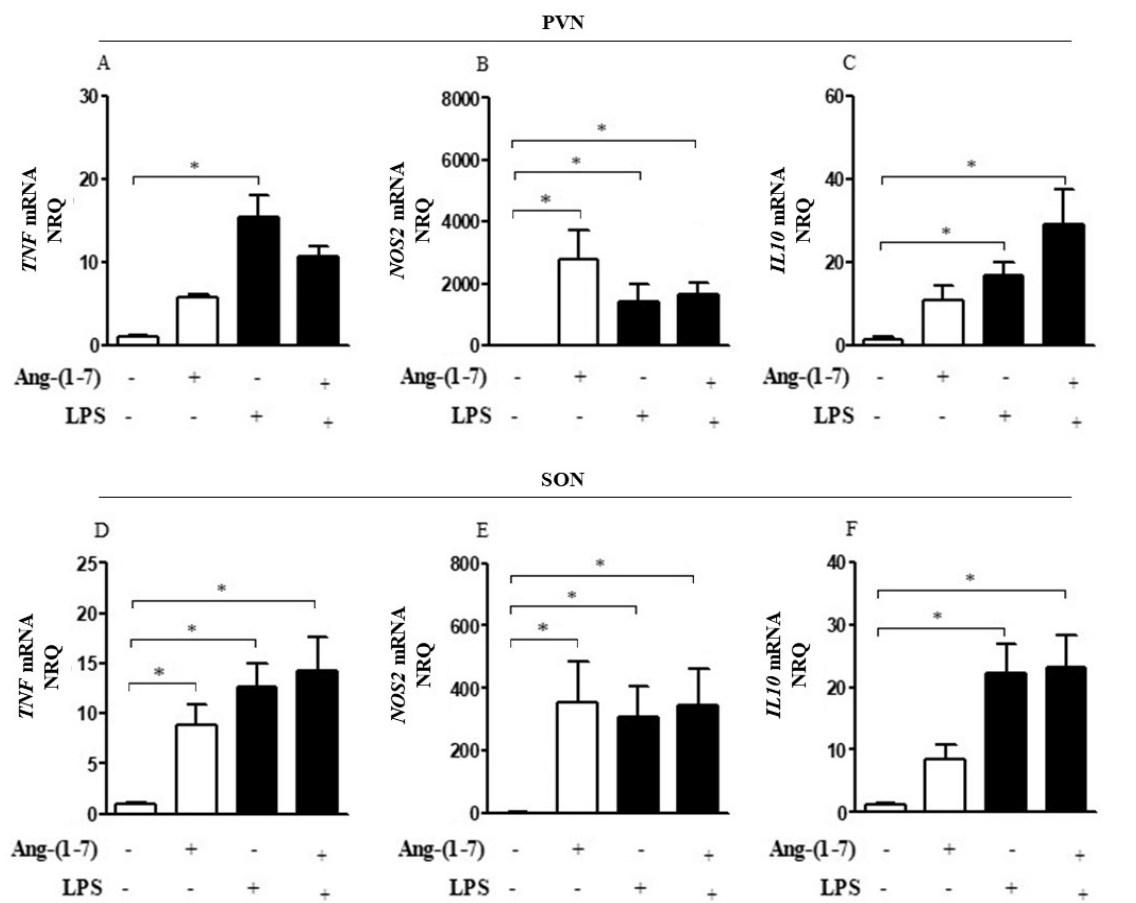
Figure 1. Central administration of Ang-(1-7) did not attenuate neuroinflammation in endotoxemia. Effect of central Ang- (1-7) on the TNF ( A , D ), NOS2 ( B , E ), and IL10 ( C , F ) gene expression in PVN and SON of rats 6 h after LPS administration (1.5 mg/Kg, i.v.). Ang-(1-7) (0.3 nmol in 2 µL, i.c.v.) was injected 1 min before LPS. Data are expressed as the mean ± SEM, n = 7–9. ANOVA, followed by Bonferroni post-hoc test. * p < 0.05 versus Saline (i.c.v.) + Saline (i.v.) group.